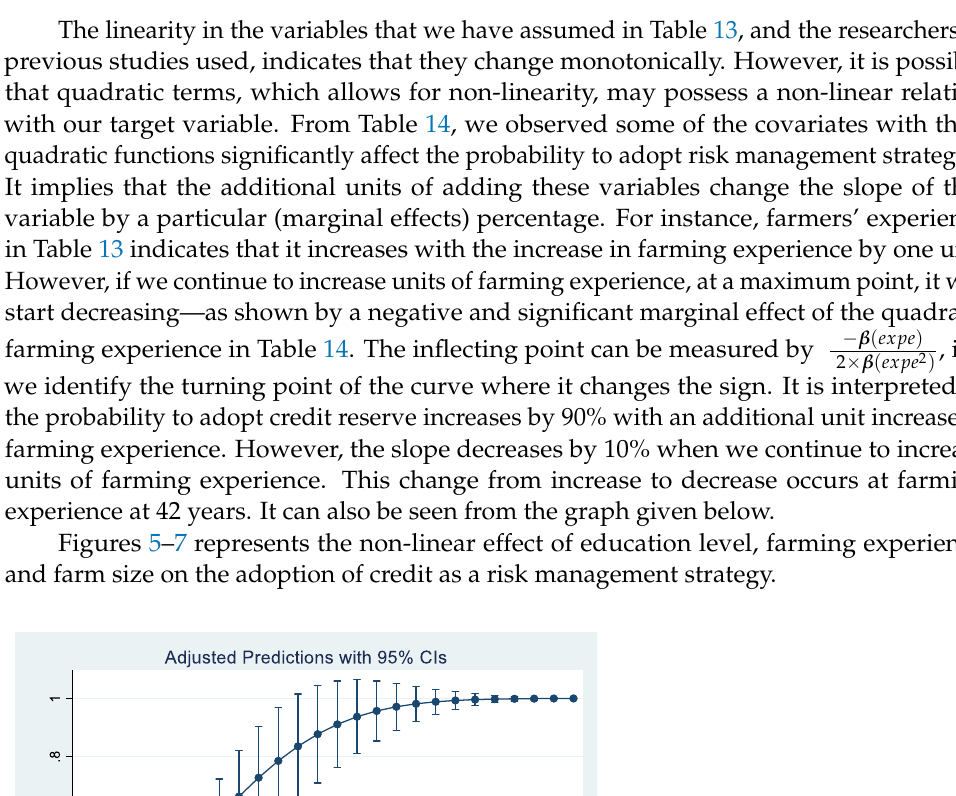
Figure 6. The non-linear impact of farming experience on the probability to adopt credit as a risk management strategy Figure 7. The non-linear impact of farm size on the probability to adopt credit as a risk manage- ment strategy Similarly, the quadratic impact of education level and farm size on the adoption of credit reserve are significant and show the turning points from increase to decrease in the slop at 8 years and 14 acres, respectively. The graphs provided in Figures 8 – 10 represents a significant non-linear impact of education, off-farm income, and farm size on the adoption of accumulated assets as a risk management strategy. The turning points are at approximately 3 years for education, 71